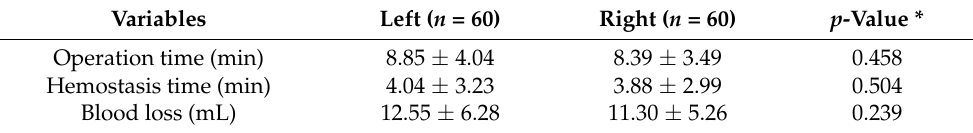
Table 3. Comparison of operation time, hemostasis time and blood loss by side of application.